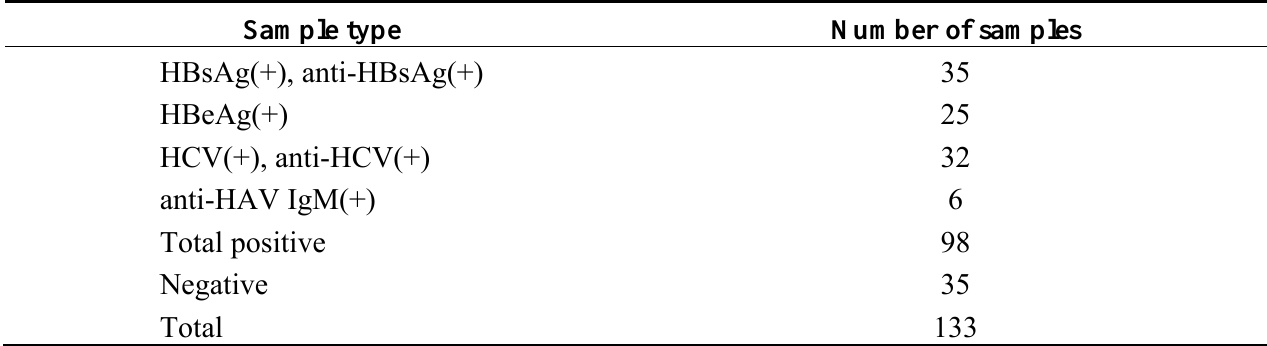
Table 1 . Classification of serum samples